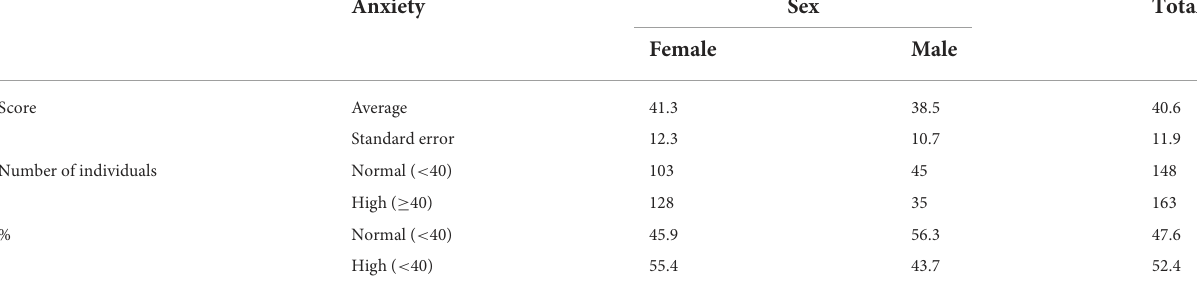
TABLE 2 Self-reported anxiety scores of the STAI-6 test of Azorean university students ( n = 311).